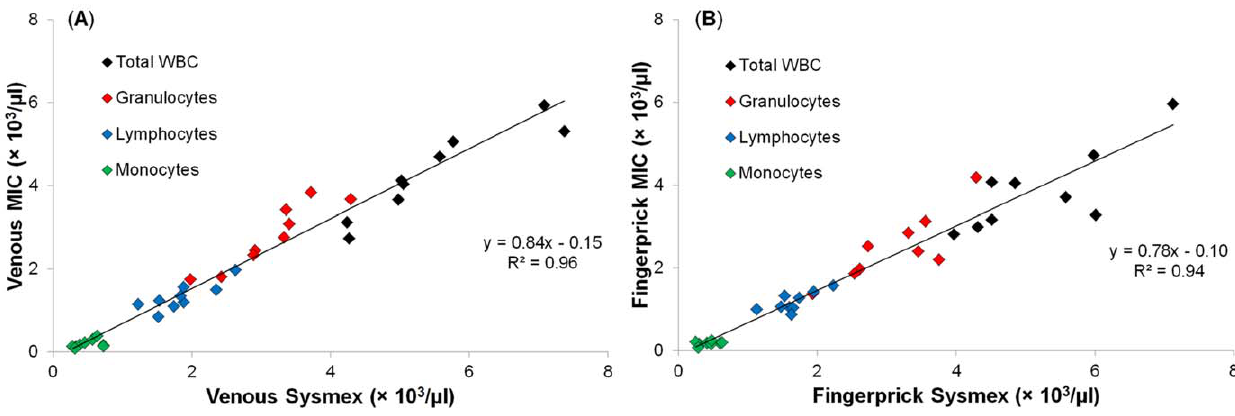
Figure 5. Concordance between same-site samples measured on standard analyzer and MIC. Concordance between Sysmex XE-2100 hematology analyzer and MIC for (A) venous (n=9) and (B) fingerprick (n=9) blood samples for total and 3-part differential leukocyte concentrations. Solid black lines show linear least-squares regression to all leukocyte populations, with first-order and correlation coefficients stated.